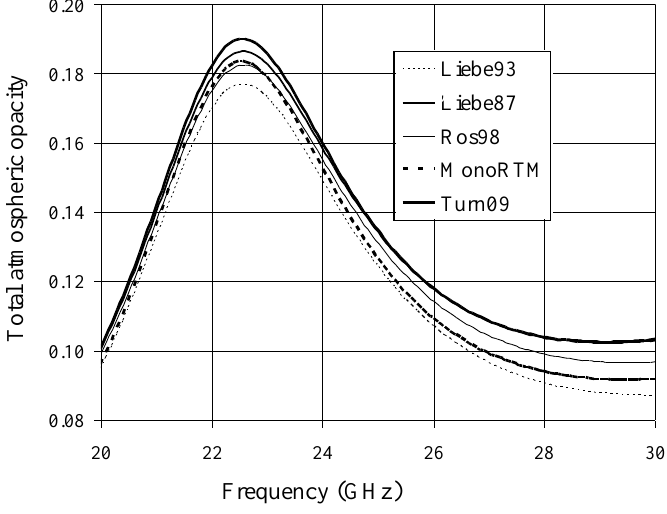
Figure 2. Total atmospheric opacity  , calculated using Liebe87, Liebe93, Ros98, MonoRTM and Turn09 water vapor absorption models for a clear sky polar atmosphere (Q = 13.9 kg/m 2 ) for the frequency range 20–30 GHz. Liebe87 is used for oxygen absorption calculation in all